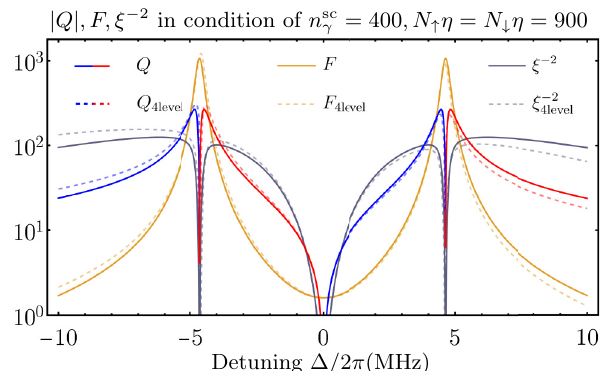
FIG. 9. Comparisons of the squeezing parameters Q , F and ξ − 2 between the three-level and four-level models. The solid lines represent the results of the three-level model (see also Fig. 5), and the dashed lines correspond to the four-level model. For Q plots, red branches stand for positive Q and blue branches for negative Q . The four-level model only provides a small correction to the three-level